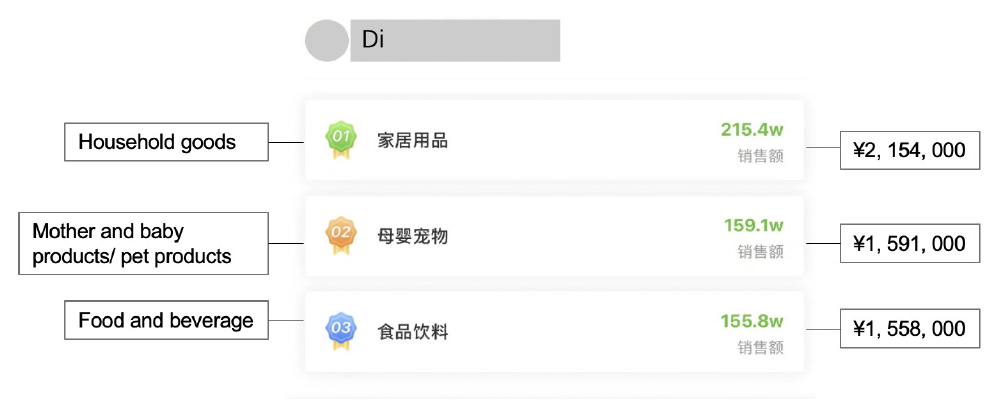
Figure 8. Di’s live streaming sales in June 2021.